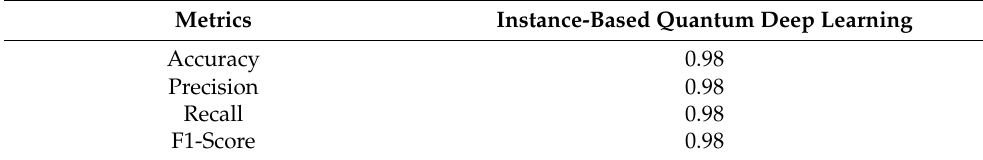
Table 5. Proposed QDL performance evaluation.